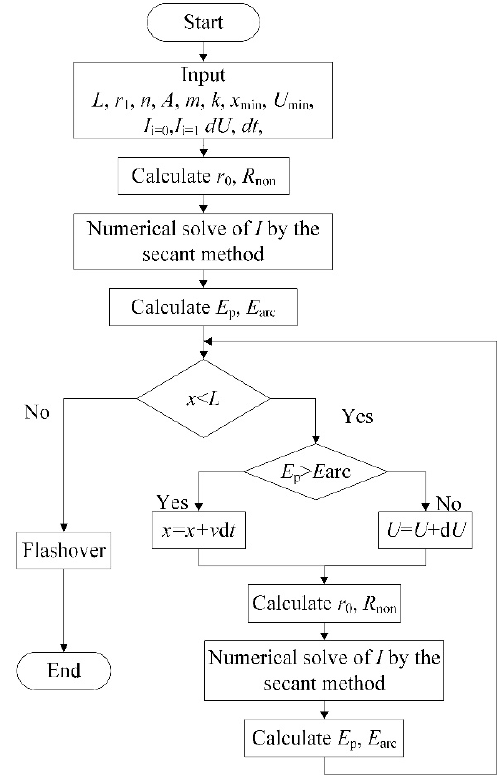
Figure 11. Flow chart of DC pollution flashover dynamic model.